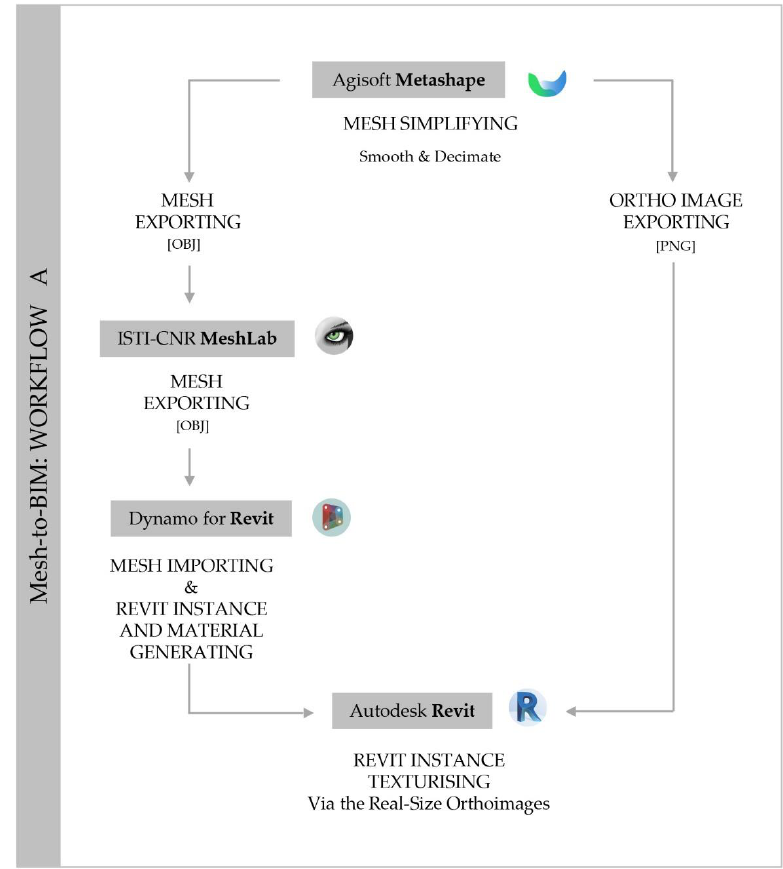
Figure 1. Procedural Workflow A scheme.